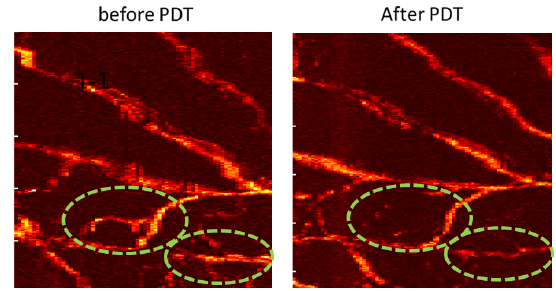
Fig. 7. Photoacoustic images of vascular structures before and after PDT. The green circles indicate the signi¯cant changes of the vascular